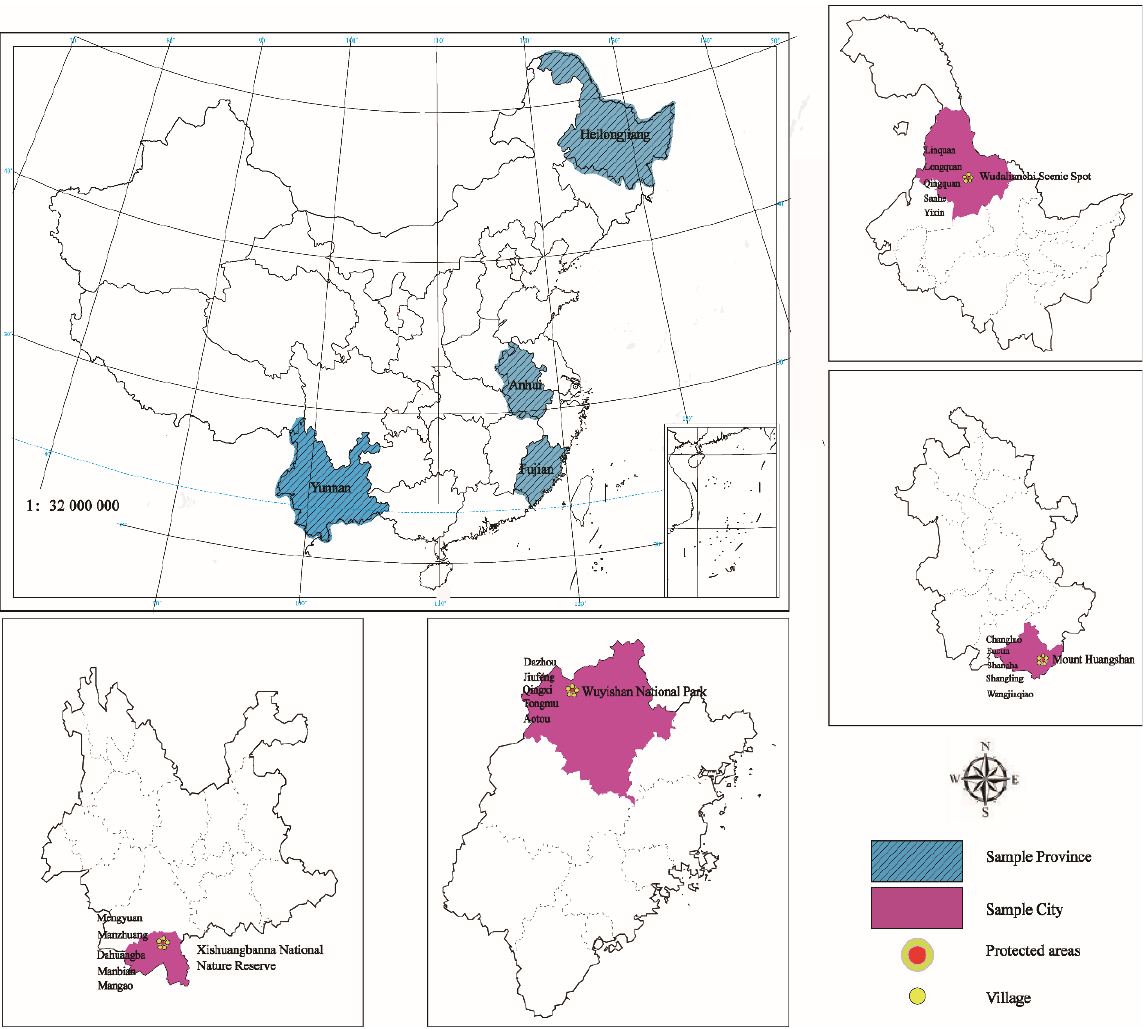
Figure 2. Study sites around four Biosphere Reserves in China.